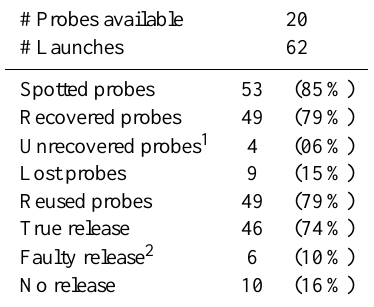
Table 1. Sounding statistics during